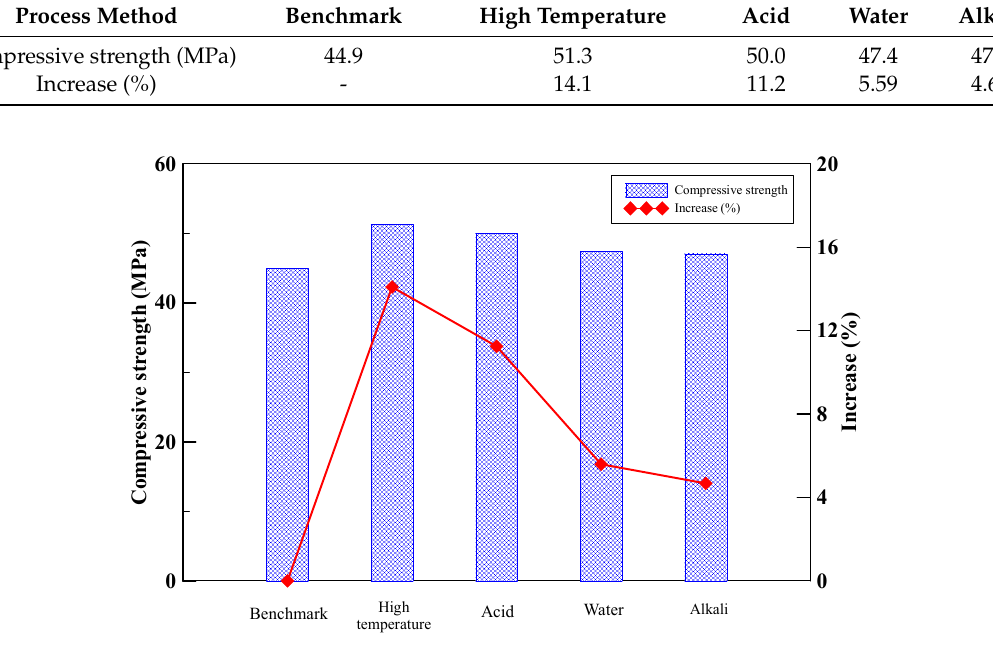
Figure 10. Bar chart of the compressive strength for benchmark (unprocessed), high temperature, acid solution, water, and alkali solution.